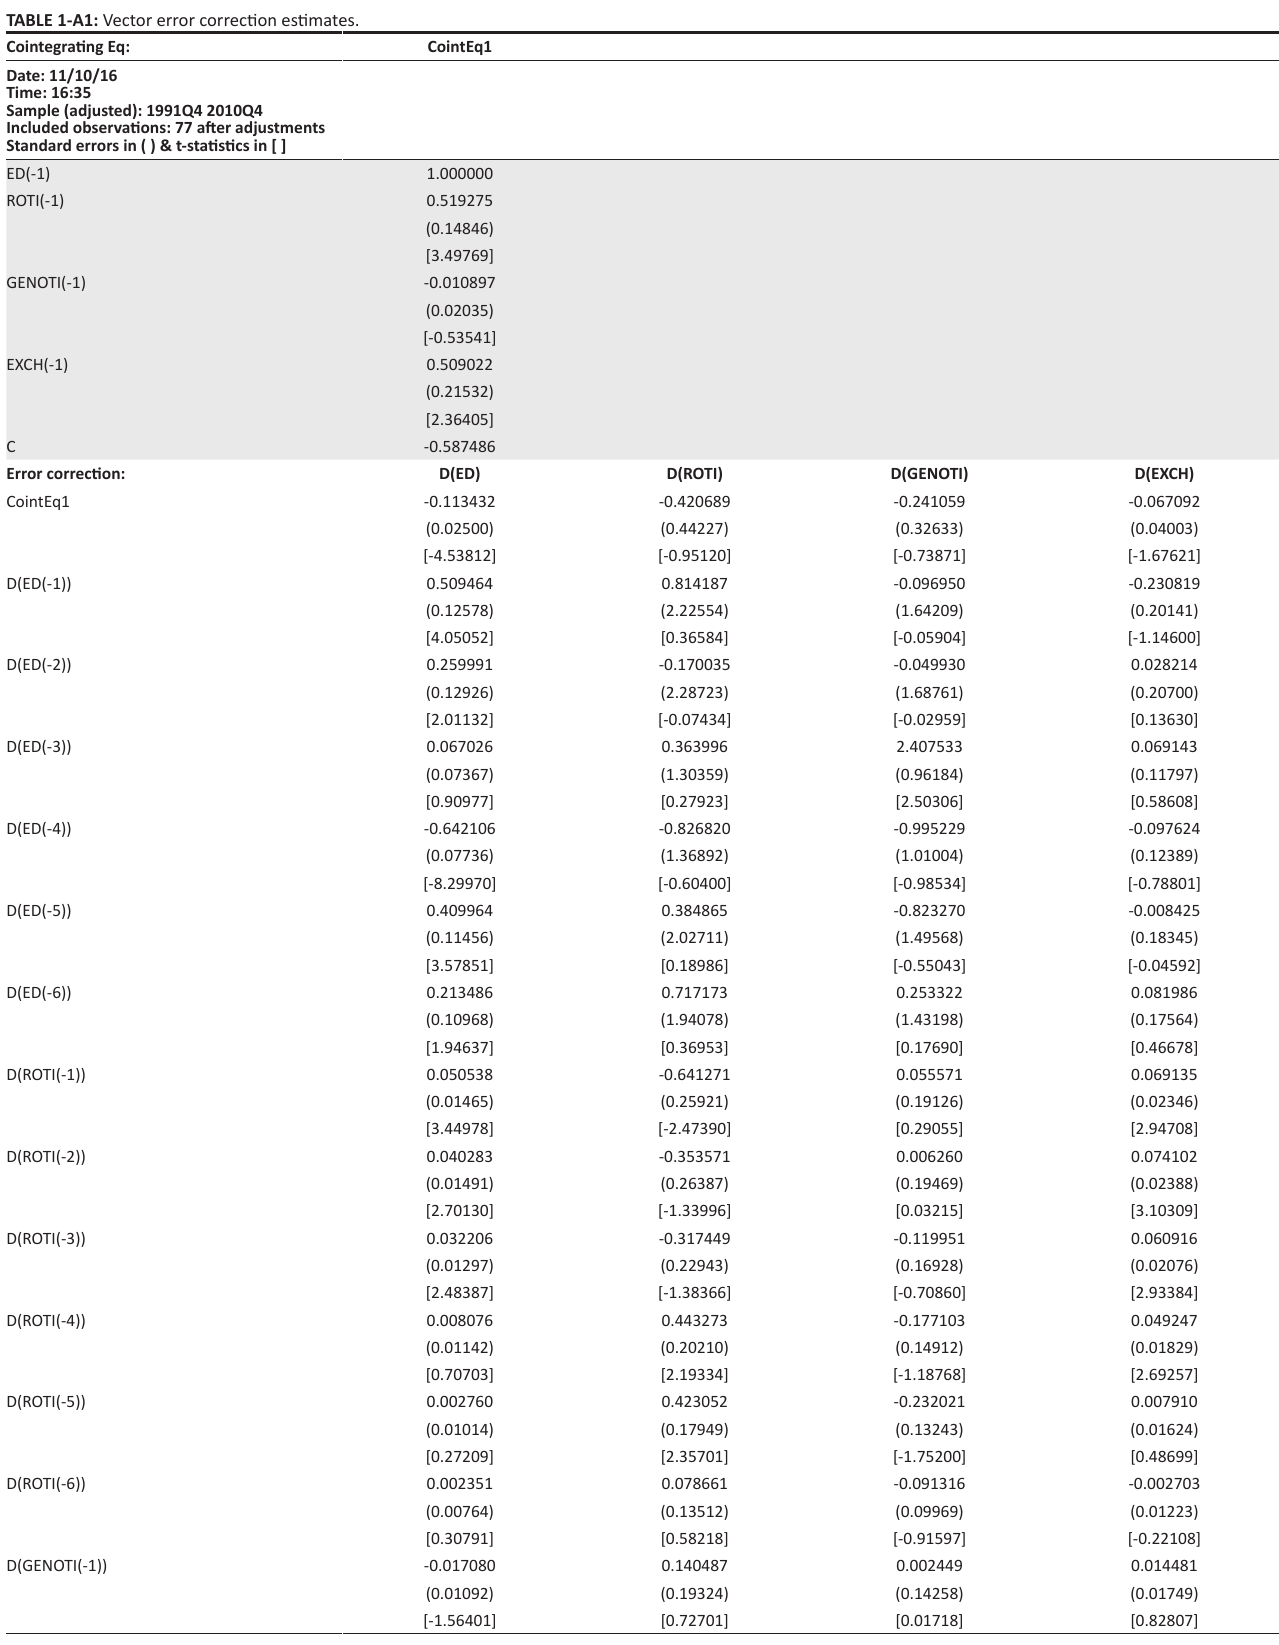
TABLE 1-A1: Vector error correction